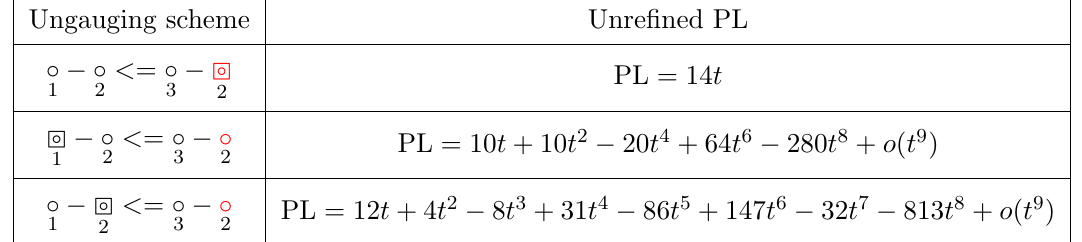
Table 2 . Di(cid:11)erent choices of ungauging schemes for the minimally unbalanced C 3 quiver. The ungauging scheme in the (cid:12)rst row has a simple re(cid:12)ned PL given by PL ref = [0 ; 0 ; 1] of the Dynkin labels of Sp(3). The ungauging in the last row yields a non-valid Coulomb